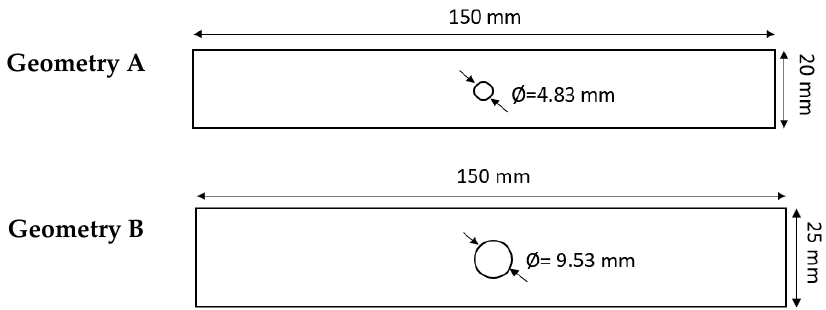
Figure 1. Geometries of the CFRP specimens. Samples of each geometry were cut considering both the longitudinal and transverse directions of the original laminate plate.